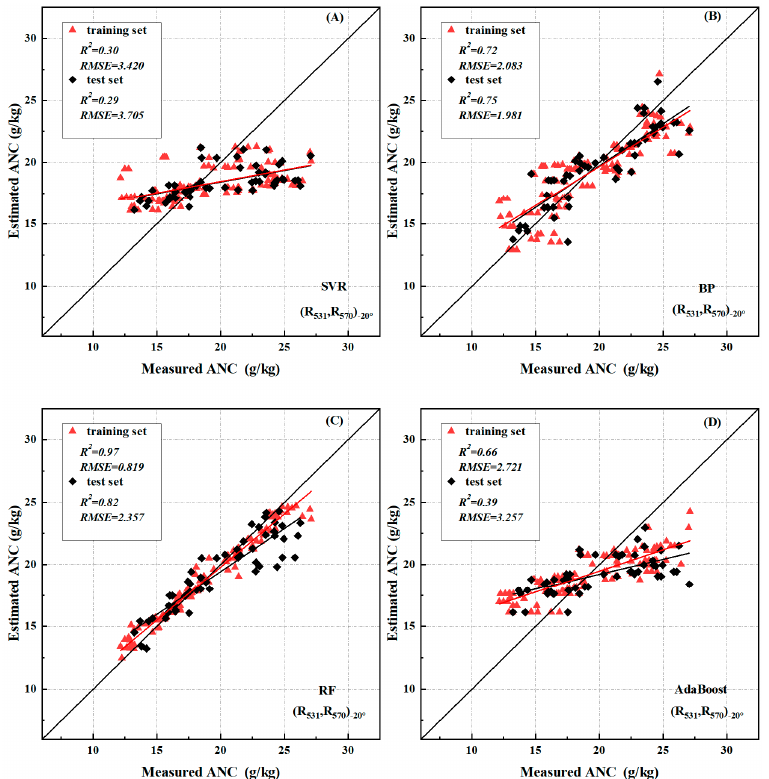
Figure 11. Machine learning modeling in the 531 nm, 570 nm bands based on spectral index PRI − 20° (n = 180, training set = 126, validation set = 54): ( A ) SVR, ( B ) BP, ( C ) RF, ( D ) AdaBoost.